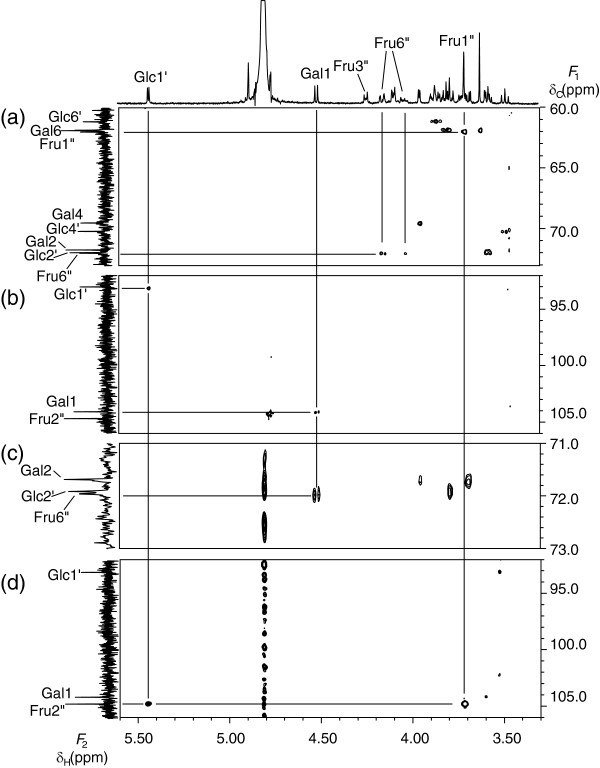
Selected parts of the HSQC (δC60.0 ppm ~ 73.0 ppm) (a), HSQC (δC92.0 ppm ~ 106.0 ppm) (b), HMBC (δC71.0 ppm ~ 73.0 ppm) (c), and HMBC (δC92.0 ppm ~ 106.0 ppm) (d) spectra of saccharide 1.